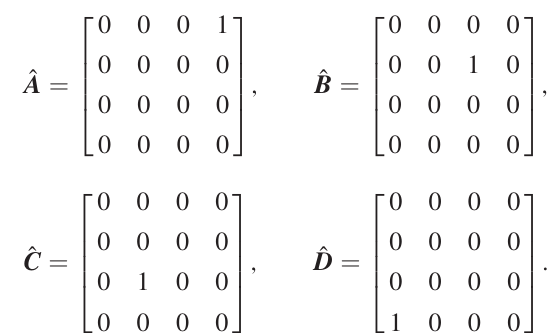
for strong scattering, l